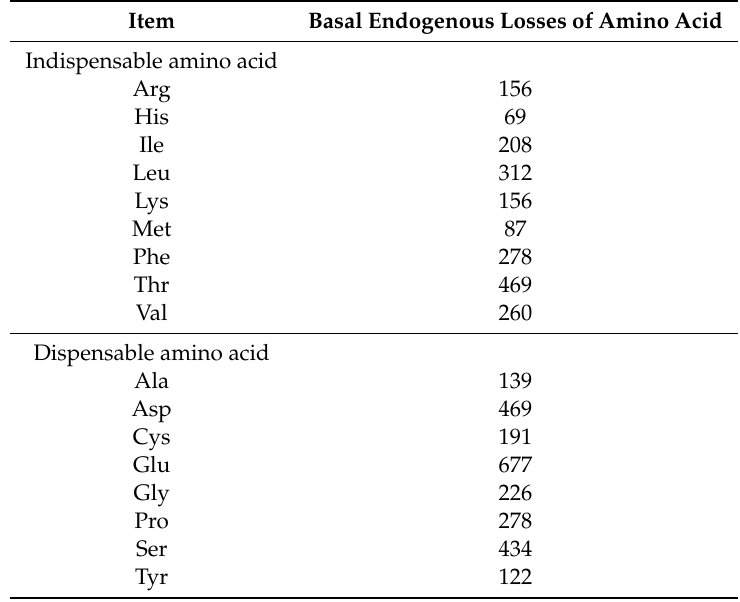
Table 4. Ileal basal endogenous losses of amino acids for broiler chickens fed the nitrogen-free diet (mg / kg DMI) 1 . Item Basal Endogenous Losses of Amino